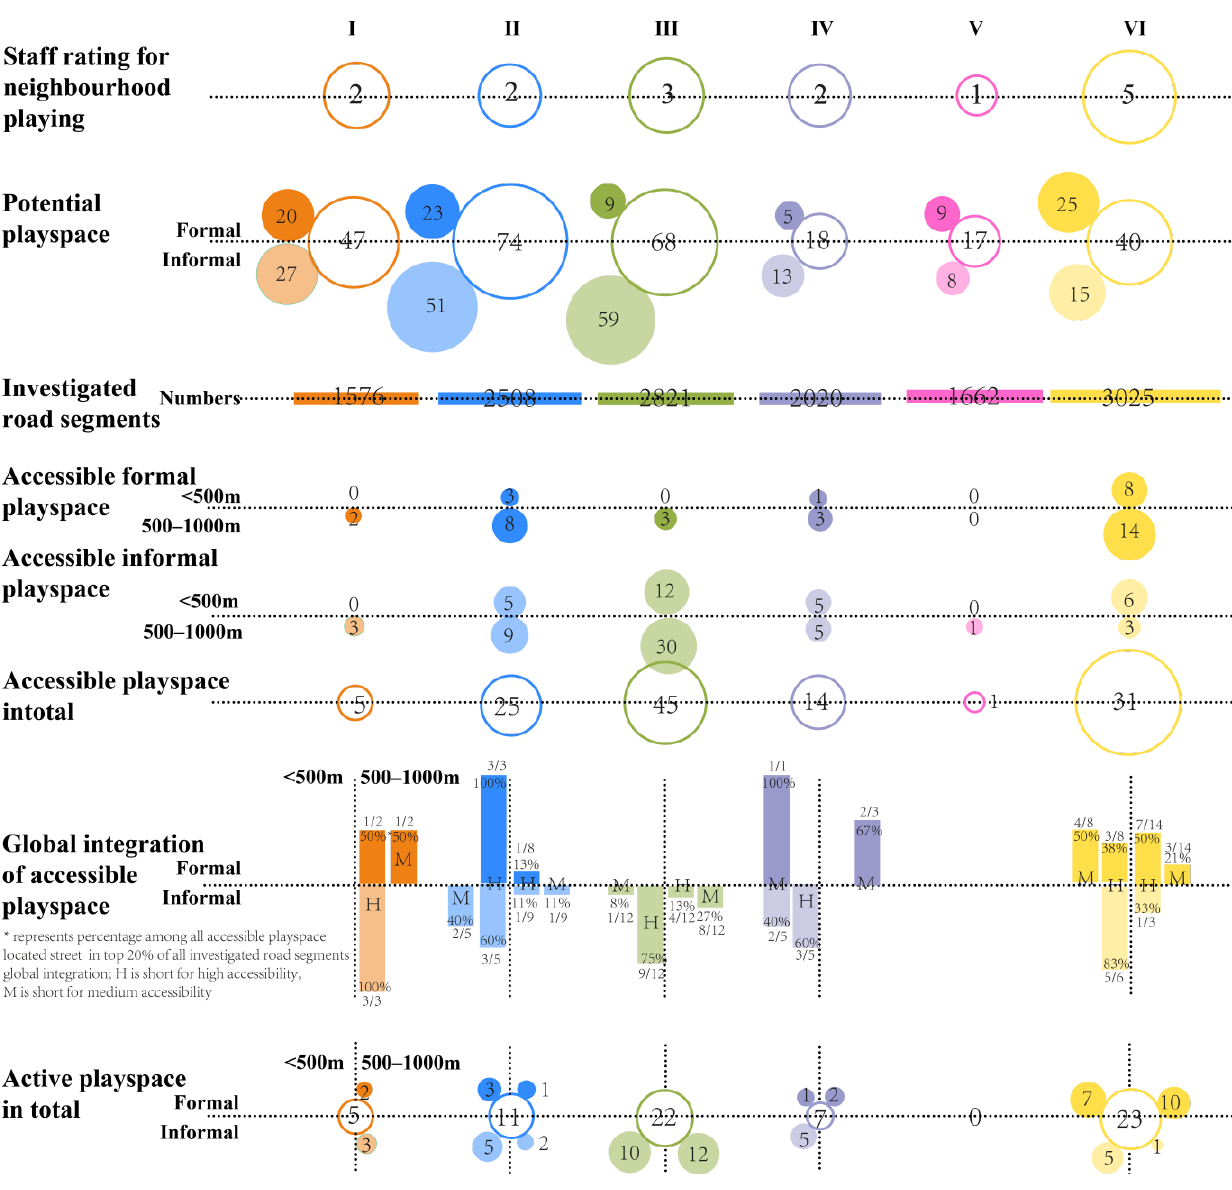
Figure 9. Overall comparison of six study sites.